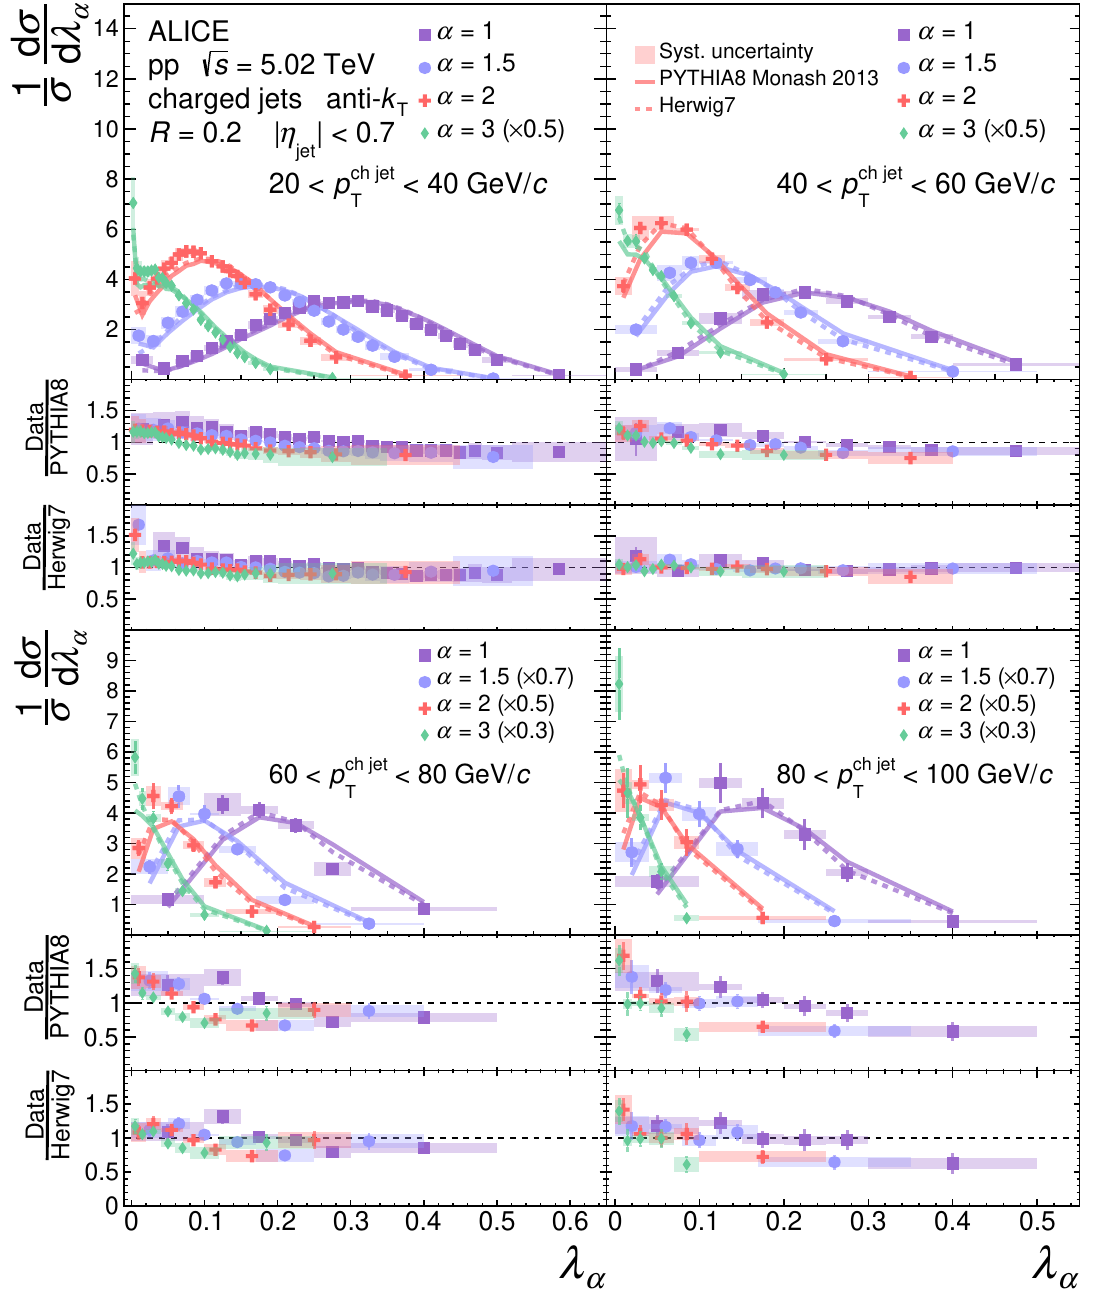
Figure 2 . Comparison of ungroomed jet angularities λ α in pp collisions for R = 0 . 2 to MC predictions using PYTHIA8 and Herwig7, as described in the text. Four equally-sized p ch jet with edges ranging between 20 and 100 GeV /c . The distributions are normalized to